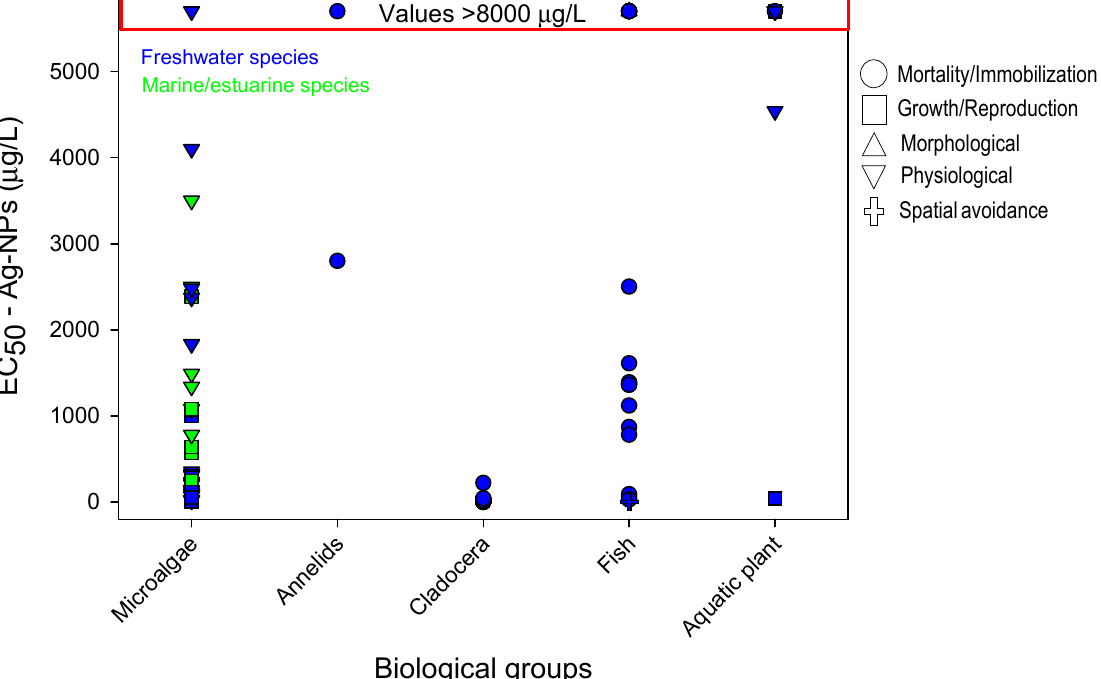
Figure 3. Sensitivity profile for biological groups exposed to Ag-NPs based on the EC 50 values. The effects, represented by different symbols, were classified according to Table 1. Data in blue and green represent, respectively, freshwater and estuarine/marine species. Data shown in the red zone represent results whose EC 50 values are higher than 8000 mg/L; therefore, the scale should not be considered in this zone (see real data in Table S3).